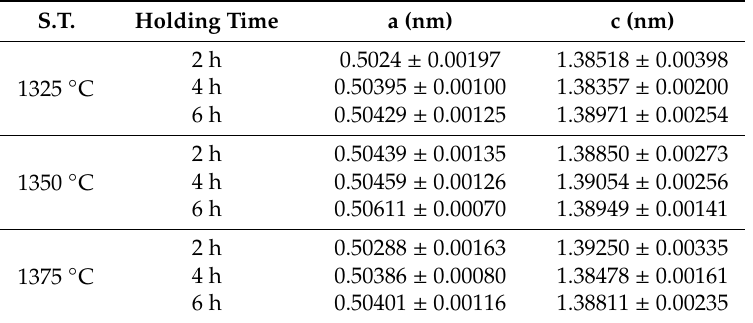
Table 1. The unit–cell constant of the MNT phase with varied holding